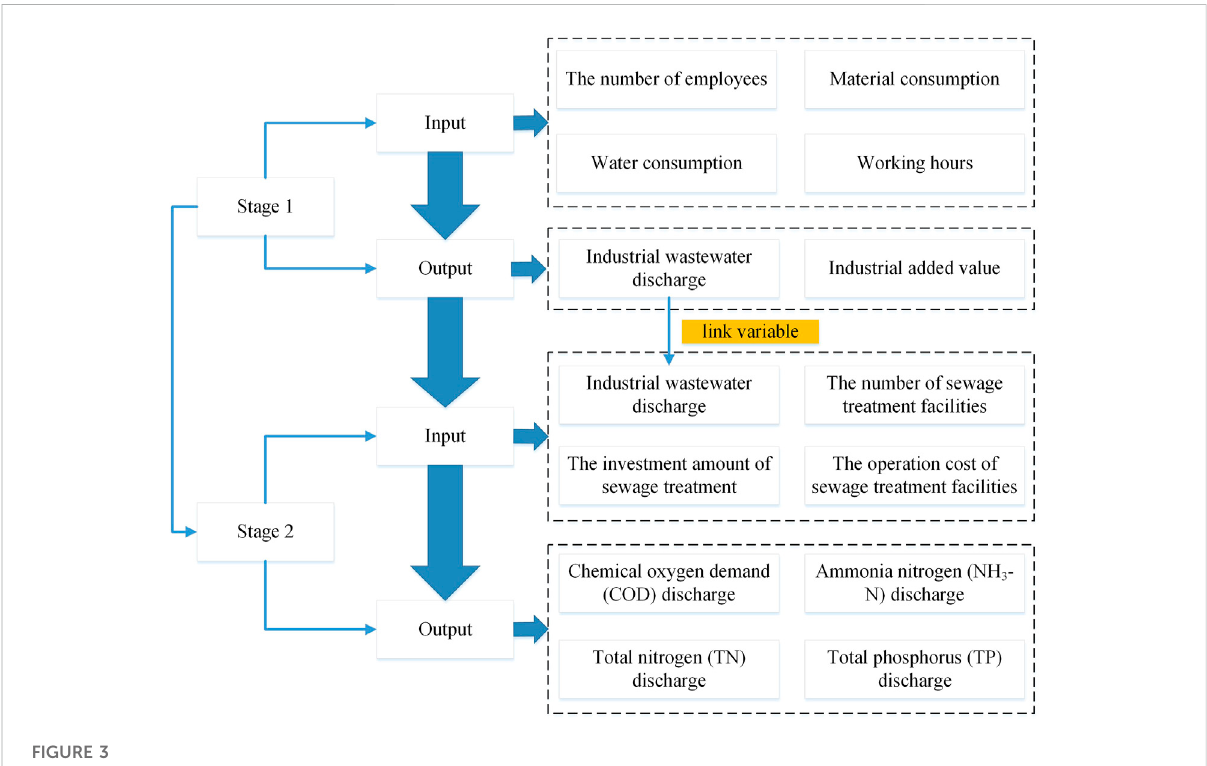
FIGURE 3 Diagram of the SBM – DEA model process.